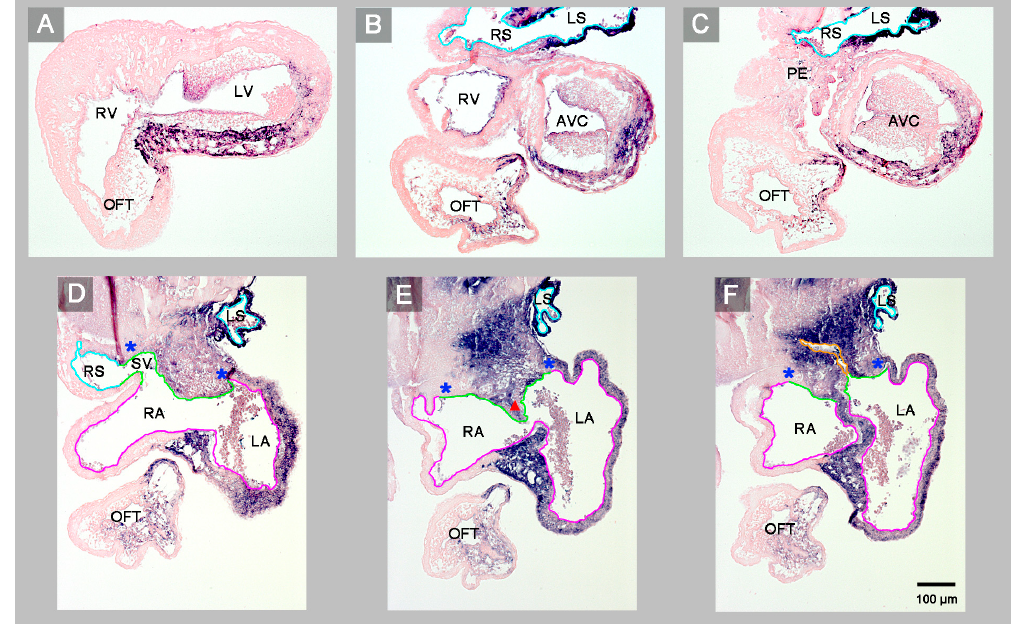
Figure 4. Starting at the level of the embryonic ventricles, this sequence of transverse histological sections depicts the Pitx2 expression pattern and the venoatrial connections of a normal HH-stage 23 embryonic chick heart. Pitx2 is expressed only in those portions of the heart that are derived from the left heart fields (left sinus horn ( B , C ), left atrium and interatrial septum ( D – F ), ventral wall of the atrioventricular canal and ventricles ( A – C )). The sinus venosus drains to the right atrium via the right portion of the atrial inflow component ( D ). The common pulmonary vein (endothelial lining marked in orange) drains to the left atrium via the left portion of the atrial inflow component ( F ). Note that the ventral wall of the right sinus horn harbors the proepicardium-derived tissue bridge ( C ). Color code for endothelial linings as used before. Abbreviations as used before. (3) The atrioventricular canal (AVC), the primitive left and right ventricles, and the outflow tract (OFT) of early embryonic hearts normally undergo a process of ventricular looping morphogenesis, which changes the original form and position of these embryonic heart segments [9]. Ventricular looping generates a helically wound bend whose outer curvature normally points toward the right body side (ventricular D-loop). This sets the scene for the development of the normal topographical relationship of the two ventricles. Looping toward the left body side (ventricular L-looping) is abnormal and sets the scene for the development of a ventricular topology that is the mirror image of the normal one. In the setting of human cardiac isomerism, ventricular looping is said to occur in a random fashion, which means that only 50% of the cases develop ventricular D-loop topology while the remaining 50% develop ventricular L-loop topology [10]. The